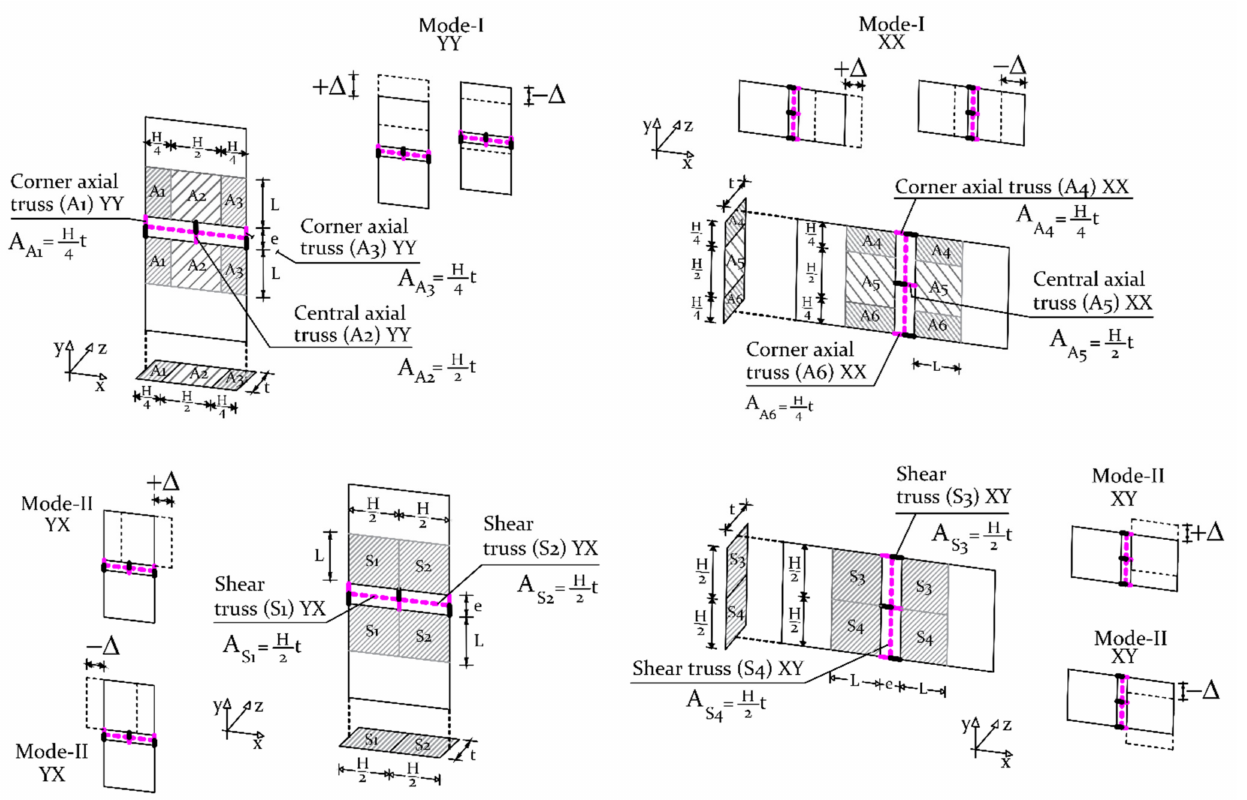
Figure 2. In–plane unit cell: a tributary area for each truss and kinematics of each allowable (admissi- ble) deformation